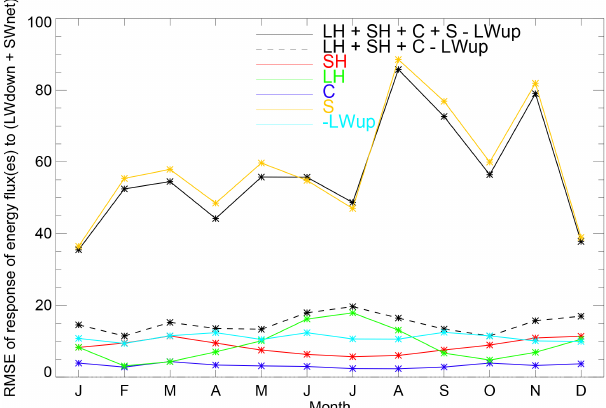
Figure 9. Annual cycle of monthly linear regression of responses to the forcing terms. The solid lines are for data spanning July 2013– June 2014 during which all SEB estimates are available. The dashed lines are representative of all available data for the given subset. Note that the y axis decreases upwards.